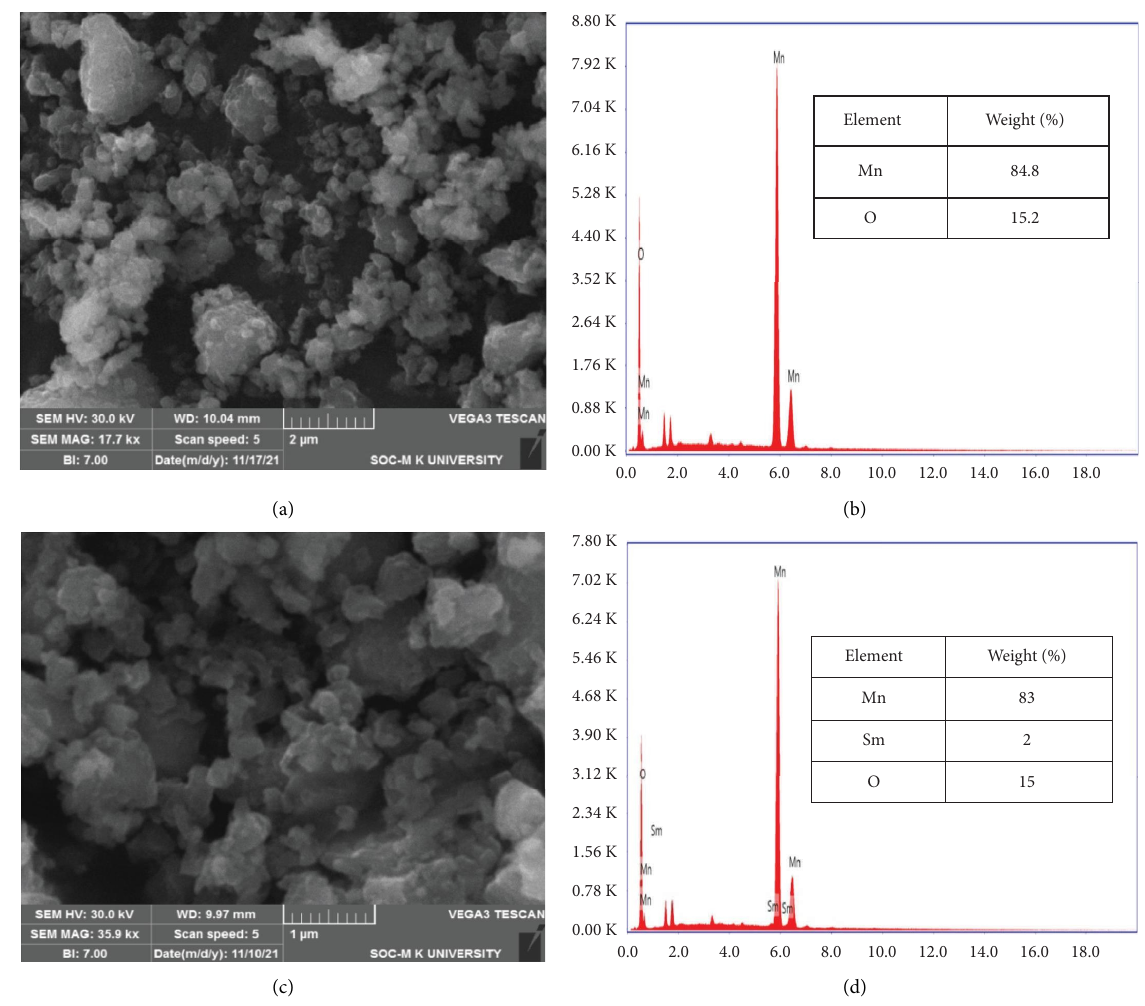
Figure 4: (a, c) SEM images and (b, d) EDX spectrum of Li